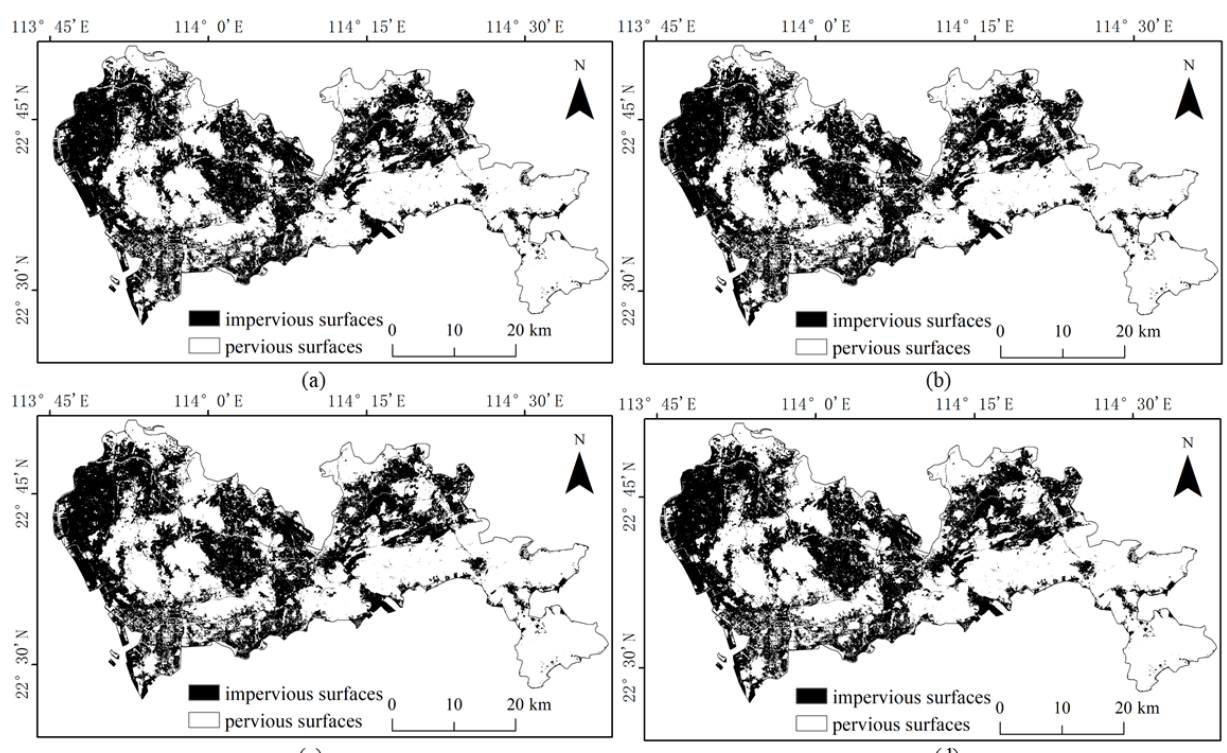
Figure 10. Results of impervious surface extraction with RF: ( a ) 80,000 samples; ( b ) 120,000 samples; ( c ) 160,000 samples; ( d ) 200,000 samples.